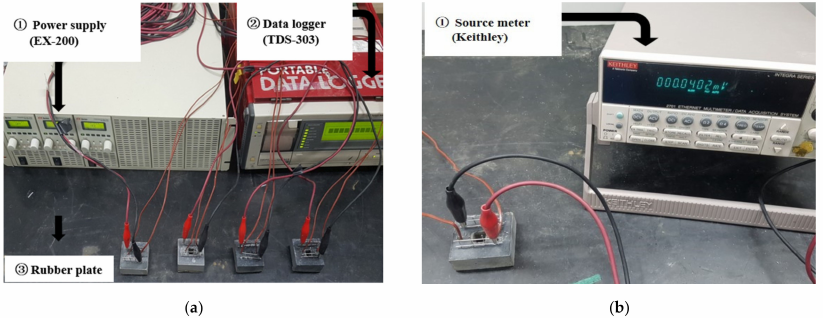
Figure 4. Experiment setup: measurements of ( a ) the temperature using a voltage supply and ( b ) the electrical